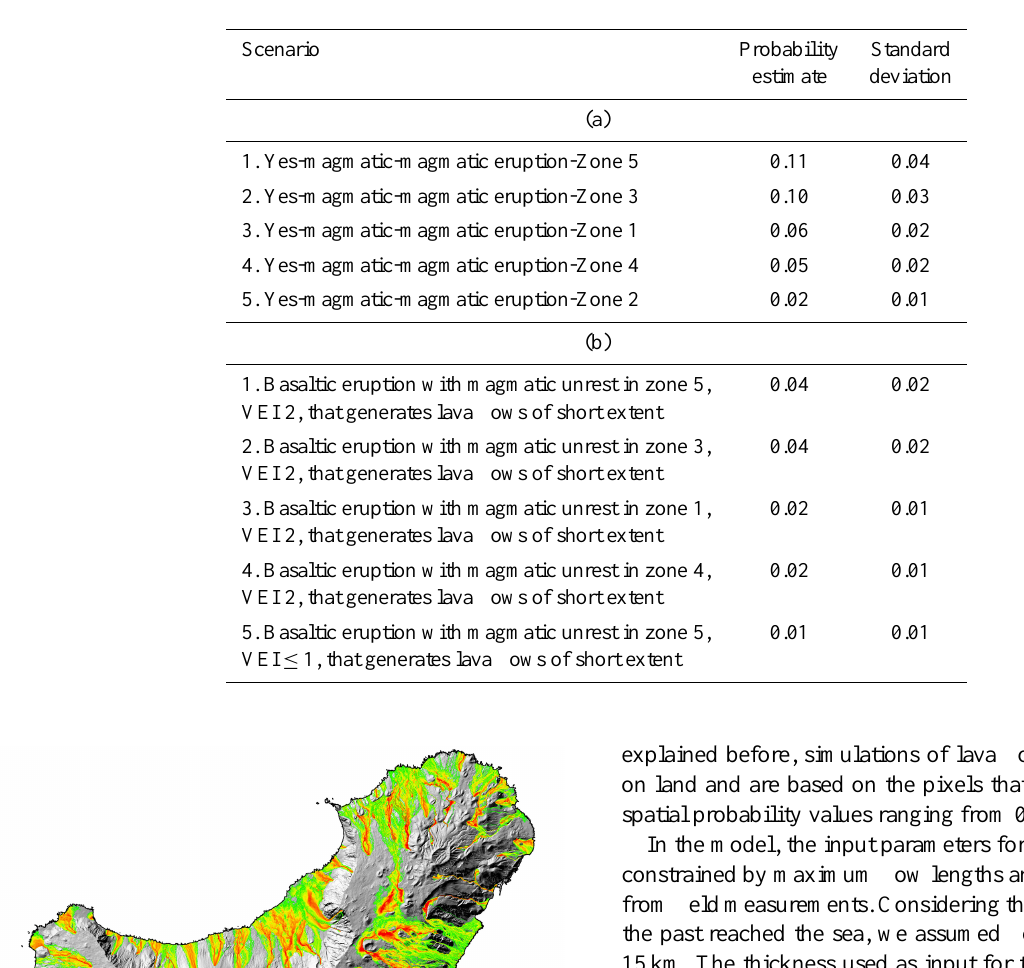
Table 3. (a) Most likely scenarios for node location. (b) Most likely scenarios for node extent.